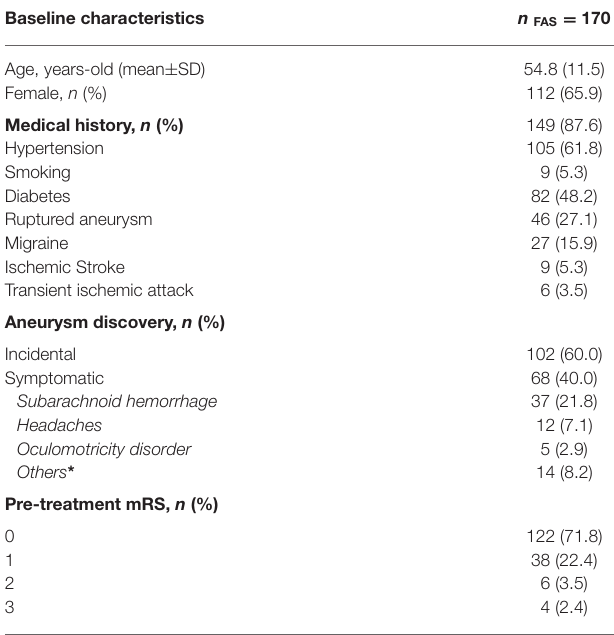
TABLE 1 | Baseline characteristics in the FAS subgroup.